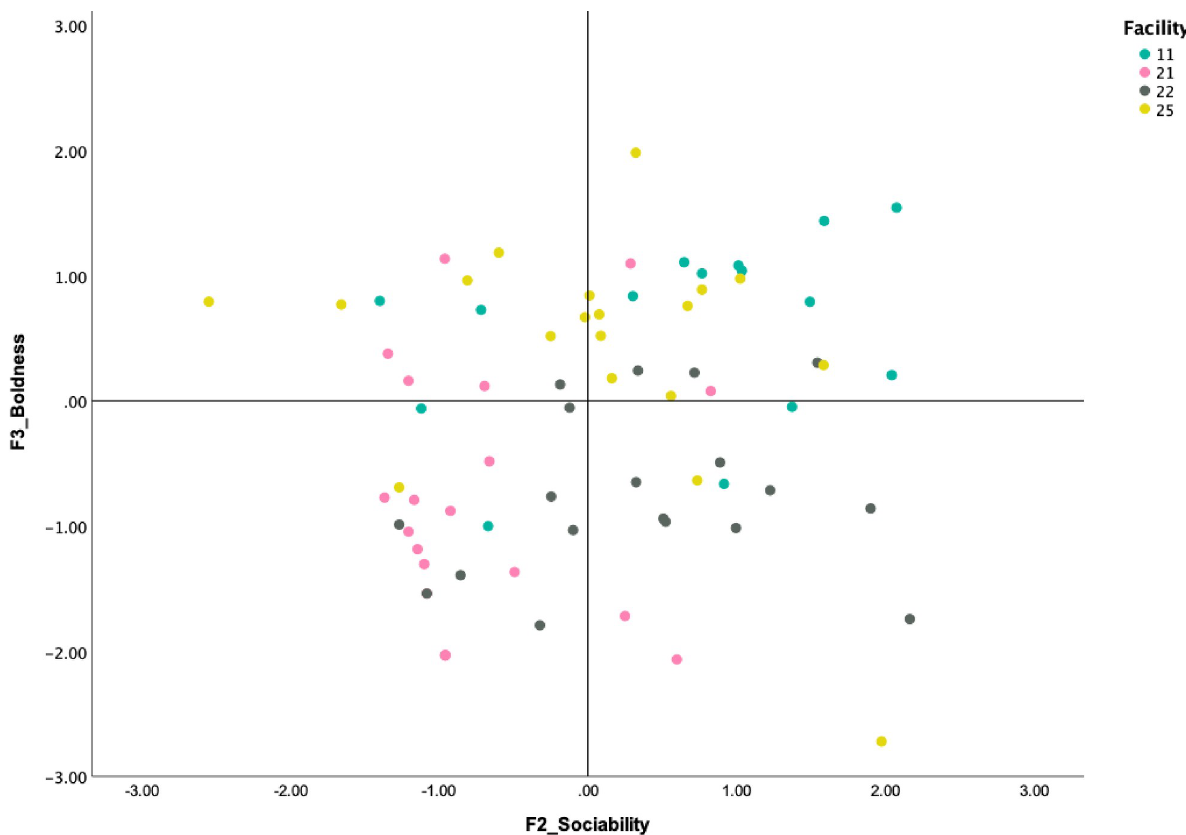
Fig 3. Example plot 1. Standardized factor scores (generated by the EFA) for each of the dogs tested in four of our facilities are plotted against two of the main behavioral factor scores extracted by the EFA: Sociability (F2) and Boldness (F3). Higher values on the X-axis represent scores for more engaging and affiliative behaviors towards the experimenter; higher values on the Y-axis represent scores for more engaging and exploratory behaviors towards inanimate objects.